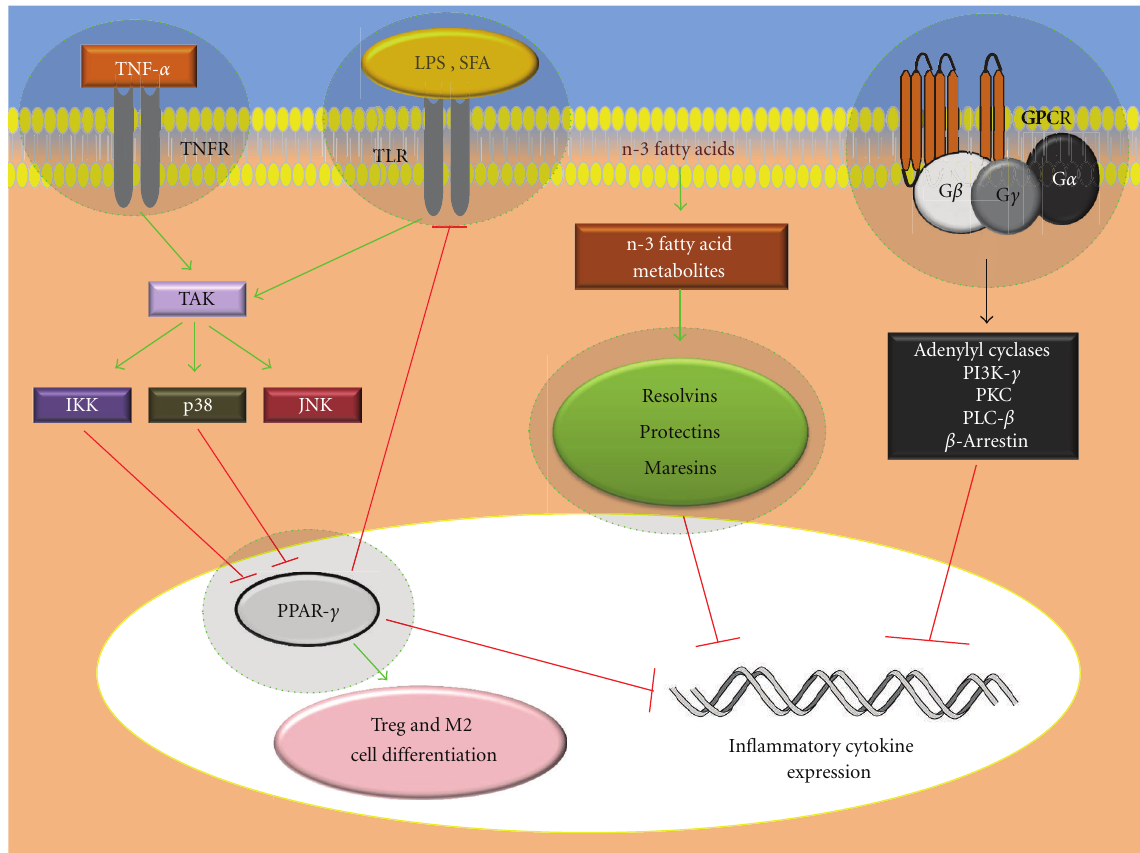
Figure 3: Potential molecular targets for reducing inflammation in insulin resistance conditions. Circulated proteins and lipid mediators are included as potential targets. Resolvins, protectins, and maresins are lipid mediators generated from n-3 fatty acid metabolism that have potent anti-inflammatory and immunoregulatory actions, promoting decreased inflammatory cytokine expression. Toll-like receptors (TLRs) are transmembrane receptors that are activated by saturated fatty acids (SFAs) and lipopolysaccharides (LPSs) inducing inflammatory responses. TLRs activate intracellular pathways that inhibit the peroxisome proliferator-activated receptor- γ (PPAR- γ activity). This transcriptional factor is involved with decreased inflammatory cytokine expression and increased Treg cell di ff erentiation. Other cytokines, including tumor necrosis factor- α (TNF- α ), also promote PPAR- γ inhibition. G-protein coupled receptor (GPCR) activation may attenuate the production of TNF- α , interleucin-6 (IL-6) and macrophage chemoattractant protein-1. GPR120 is a GPCR activated by n-3 fatty acids in insulin resistance models. COX: cyclooxygenase; IKK: I κ B kinase; JNK: c-Jun NH(2)-terminal kinase; PI3K- γ : phosphatidylinositol 3- kinase- γ ; PKC: protein kinase C; PLC- β : phospholipase C- β